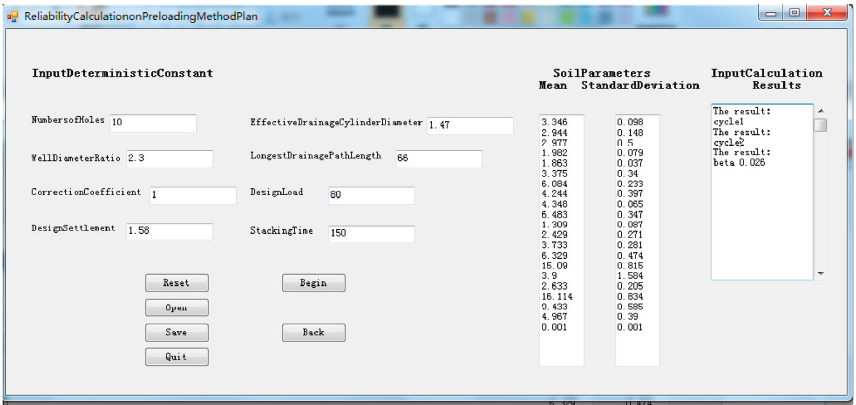
Figure 10: The test result of the preloading method reliability